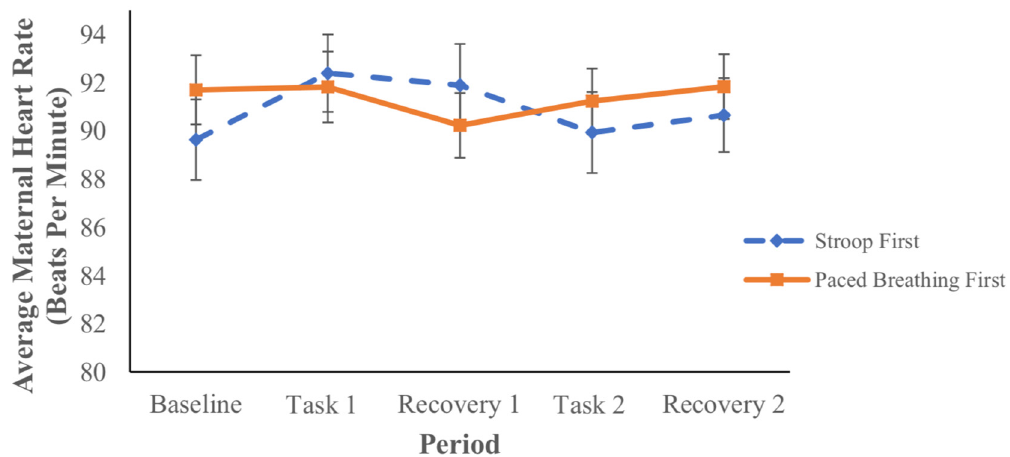
Figure 4. Maternal HR During Each Study Period By Group.